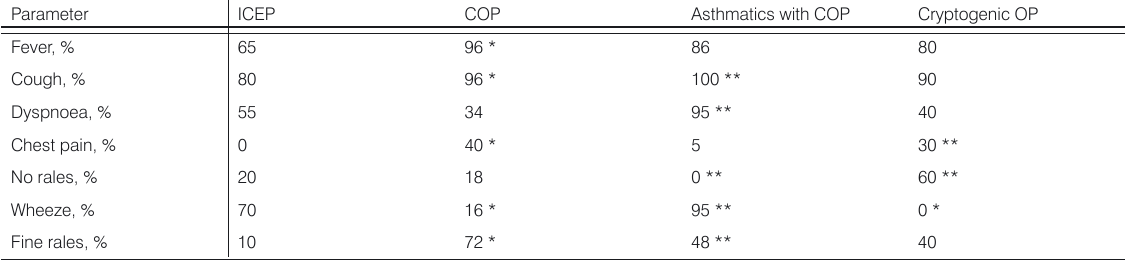
Table 3. Complaints and auscultation data of the study